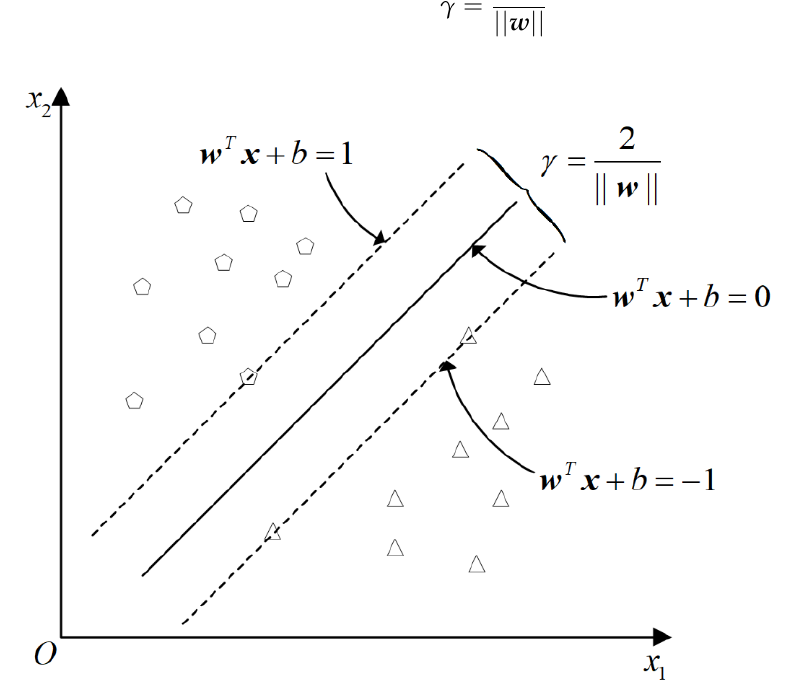
Figure 4. Schematic diagram of support vector machine.